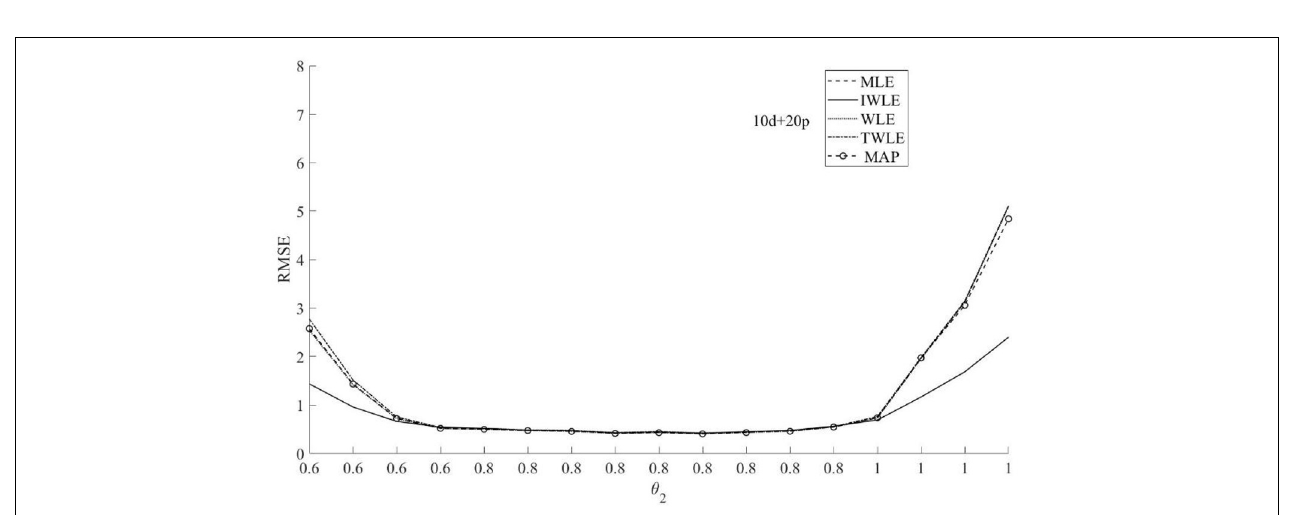
FIGURE 7 | RMSE of the five θ 2 estimation methods MLE, MAP, IWLE, WLE, and TWLE for 15d+15p.